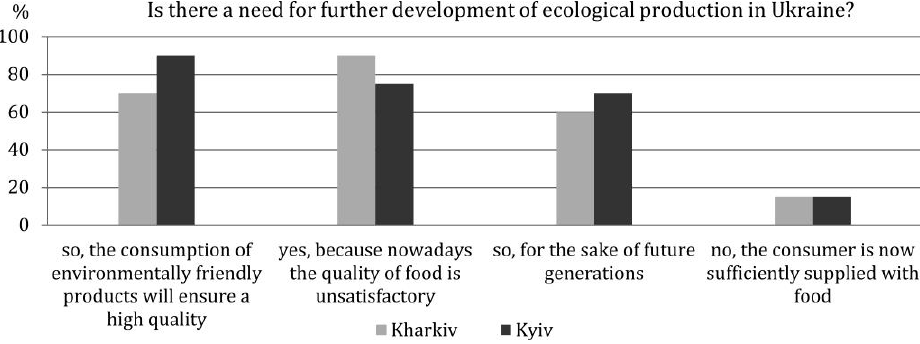
Fig. 13. Interests of respondents in further development of ecological production in Ukraine (Source: author's research)